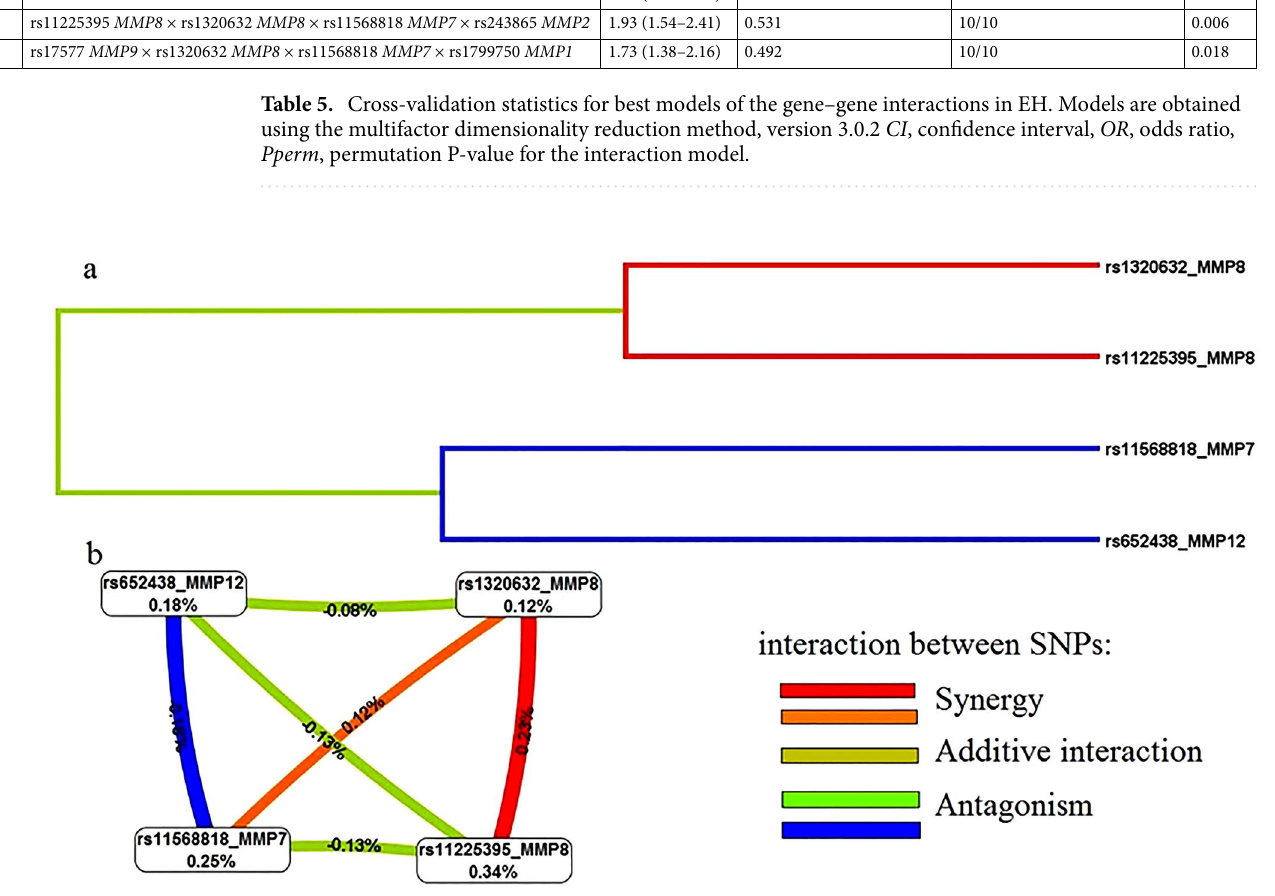
Figure 1. High-order gene–gene interaction analysis for SNPs of matrix metalloproteinases in EH (data obtained by Multifactor Dimensionality Reduction, version 3.0.2): ( a ) Interaction dendrogram; ( b ) Interaction entropy